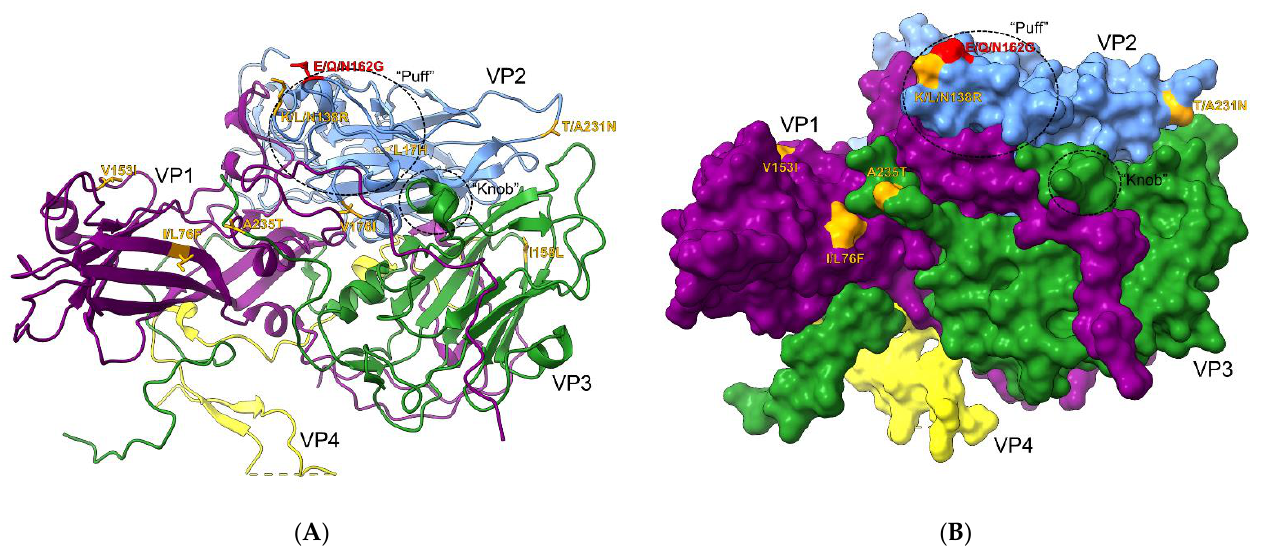
Figure 3. Echovirus 7 capsid protein structure (PDB ID 2X5I) depicting unique amino acid mutations. Circled “puff” and “knob” regions are known to hold majority of DAF contact residues. ( A ) Ribbon view of the asymmetric subunit with unique mutations found in Rigvir ® in orange. A mutation in red indicates a change directly in the DAF contact-forming residues. ( B ) Surface projection of the asymmetric subunit. Visible mutations in orange and red exhibit sufficient surface exposure.